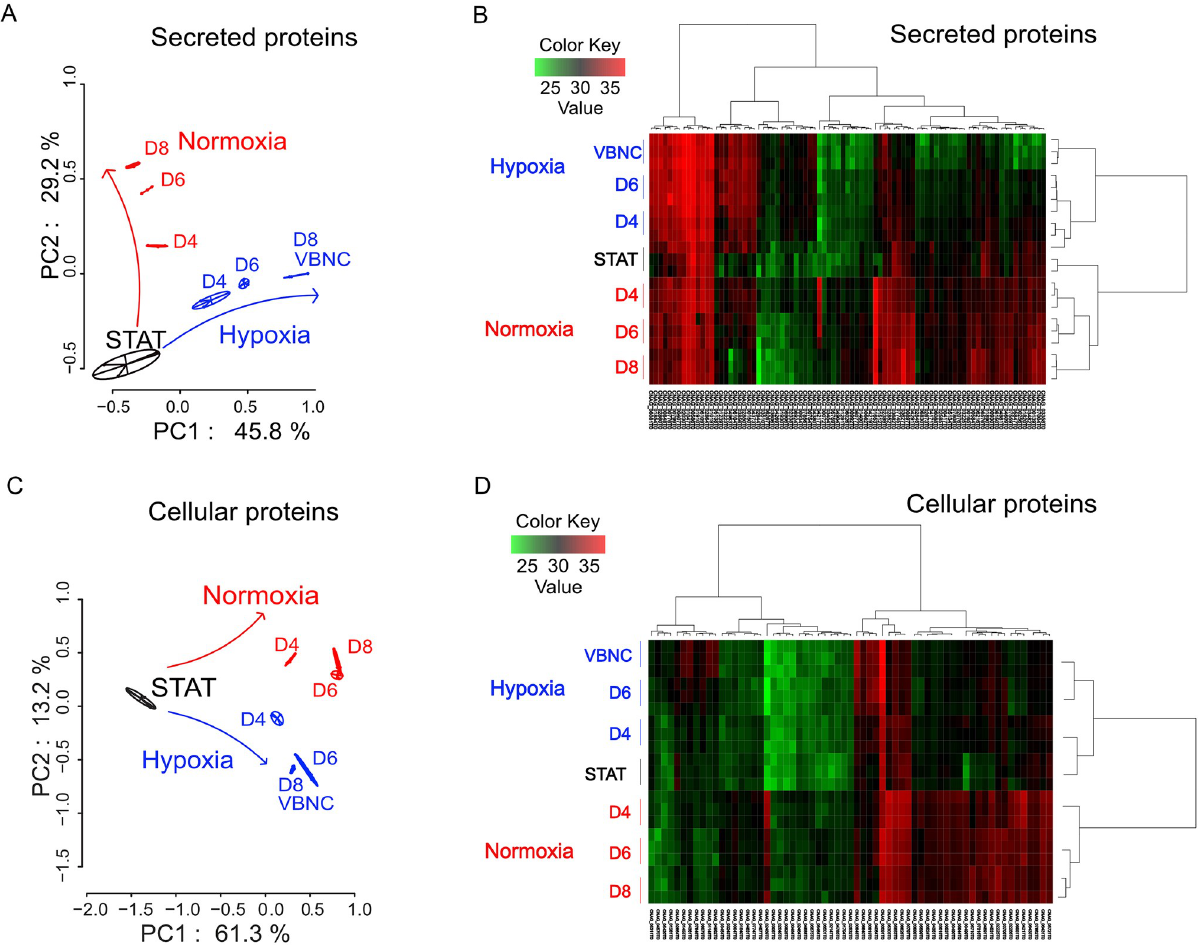
Fig 7. Secretome (A,B) and proteome (C,D) quantitative analysis showed an independent and specific kinetic evolution associated with VBNC generation. Principal coordinate analysis (PCoA) of secreted A . or cellular C . proteins and heatmap obtained by Limma analysis of secretome B . and proteome D . data. For the secretome, 85 proteins were differentially expressed overtime, including 49 significantly overexpressed in control and 36 in hypoxia. For the proteome, 63 cellular proteins were differentially expressed during kinetics including 47 significantly overexpressed in normoxia and 16 in hypoxia. Inversely of B , Data sets D showed that the STAT and hypoxia are closer than to normoxia. Biological triplicates were used for